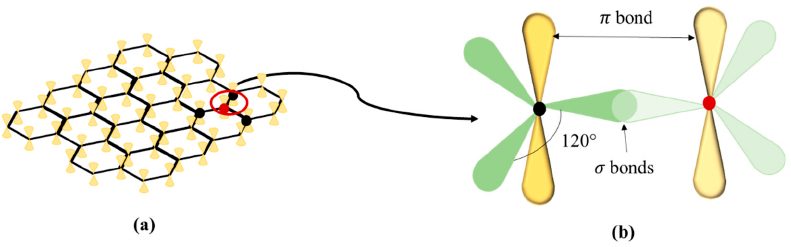
Figure 4. ( a ) Structure of graphene with pi orbitals, ( b ) sp 2 configuration in graphene.